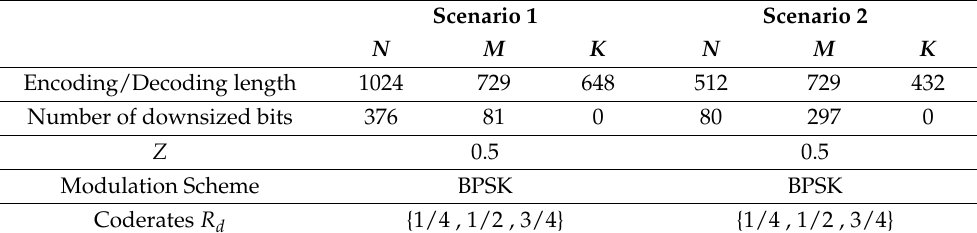
Table 1. Parameter settings for the simulation